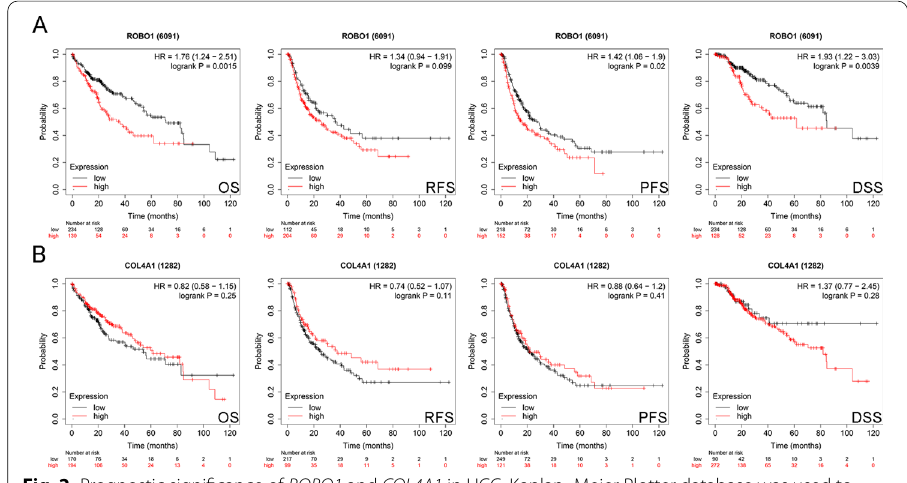
Fig. 2 Prognostic significance of ROBO1 and COL4A1 in HCC. Kaplan–Meier Plotter database was used to evaluate the prognostic significance of ROBO1 ( A ) and COL4A1 ( B ) in HCC